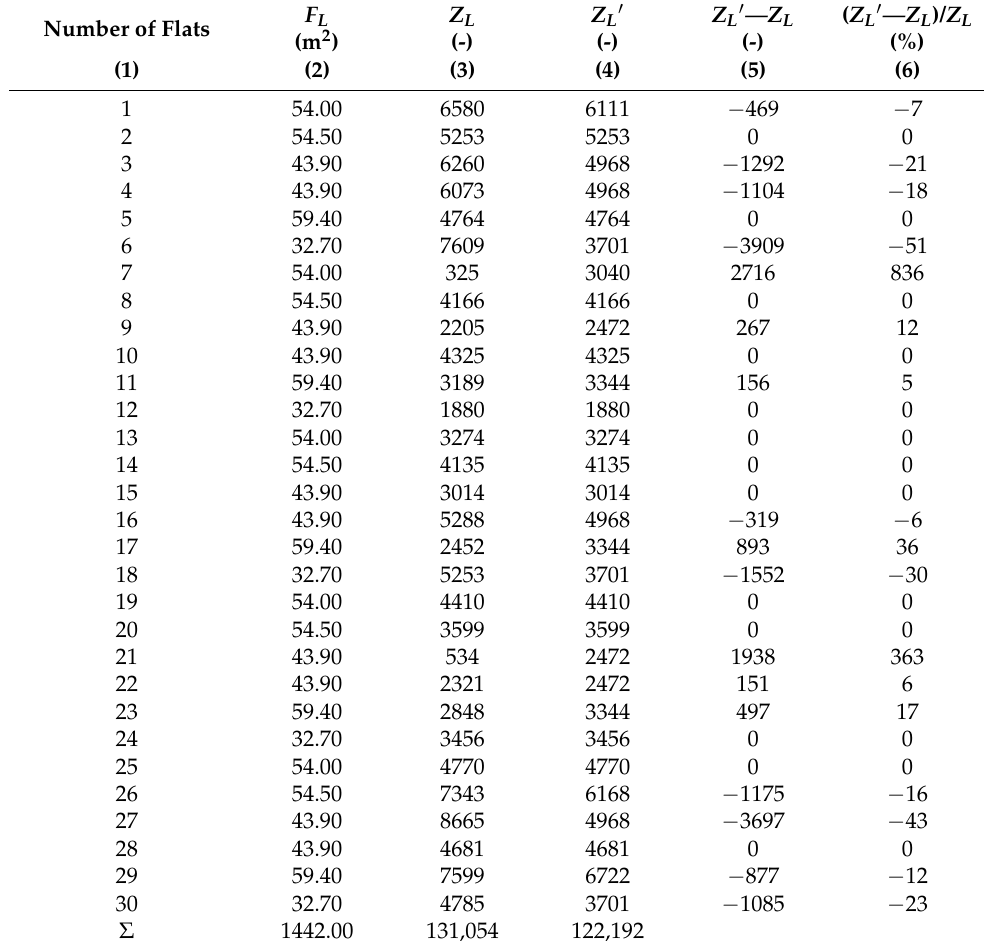
Table 3. Data and results of the variable heat costs allocation in the analysed building using method 5 ( scheme B ) without taking into account the LCF